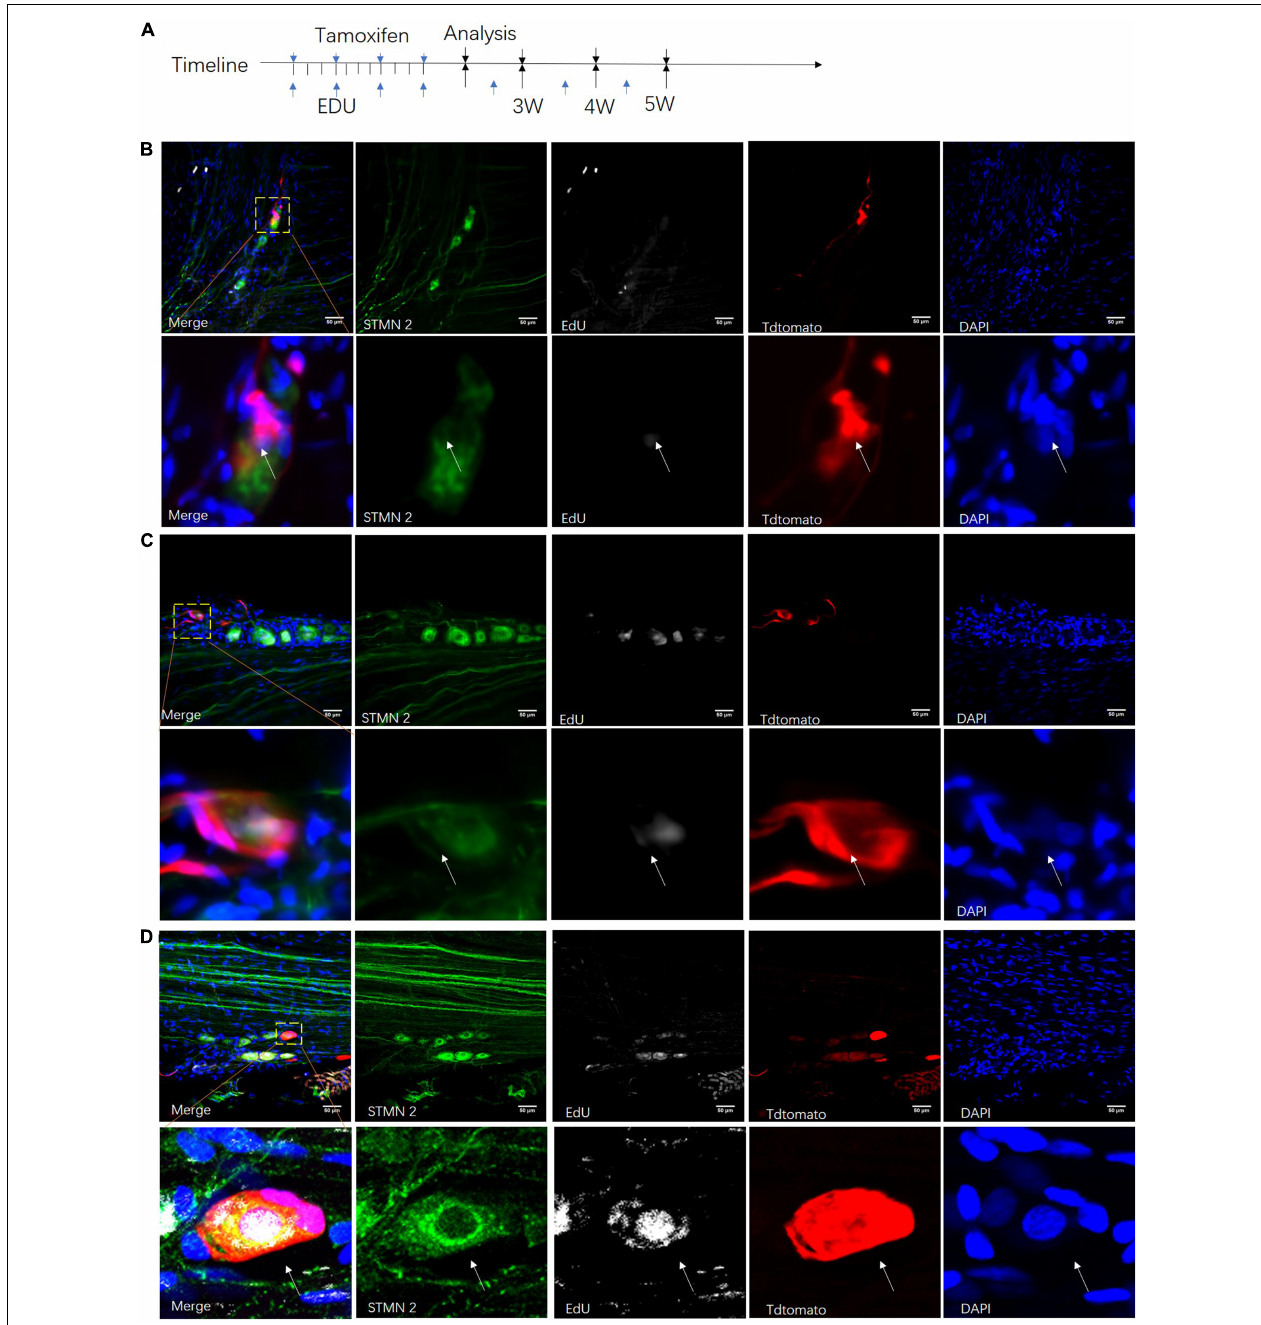
FIGURE 7 | Proliferation of neuronal stem-like cells in the sciatic nerves of transgenic rats. (A) Adult Nestin-CreER T 2 ::Tdtomato rats were given injections of tamoxifen and EdU at different time points for clonal lineage-tracing analysis. (B–D) Confocal images of Stmn2-labeled cells (green) co-labeled with TdTomato (red), EdU (gray), and DAPI (blue) after tamoxifen and EdU injection for 3–5 weeks. Scale bar, 50 µ m. n = 5 for each time point. The white arrow points to the positive